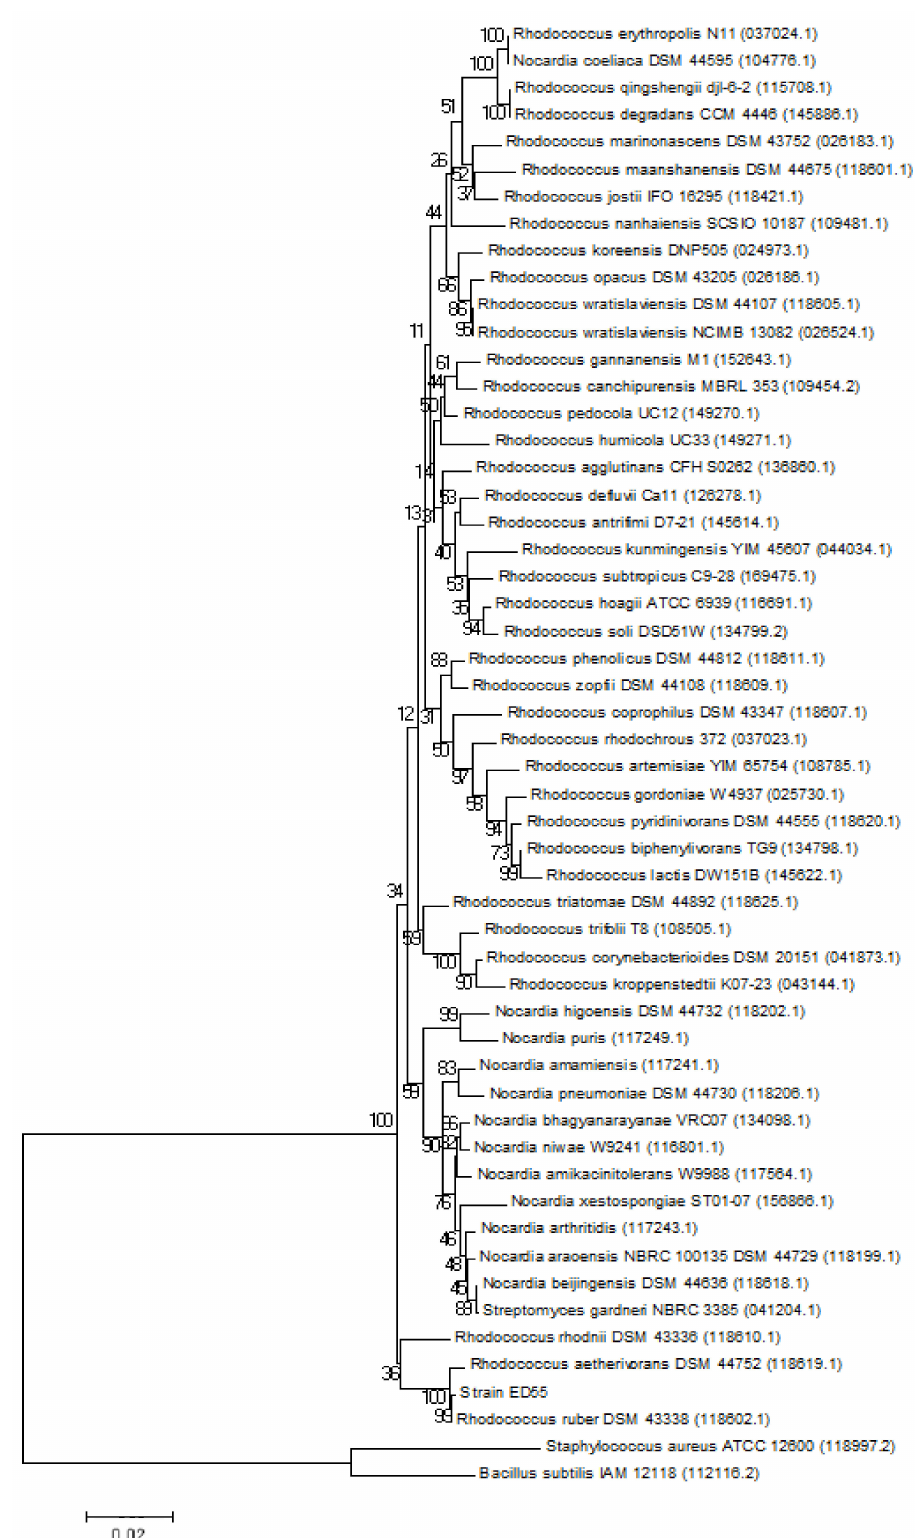
Figure 1. Neighbor-joining phylogenetic tree based on 16S rRNA gene sequences, showing the nearest neighbors of strain ED55. Bacillus subtilis and Staphylococcus aureus type strains were used as the outgroup. GenBank accession numbers are given in parentheses. The bar represents 0.02 substitutions per